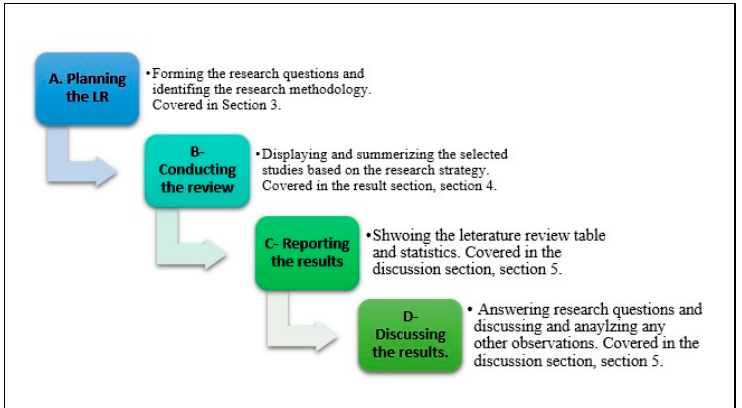
Figure 1. Research